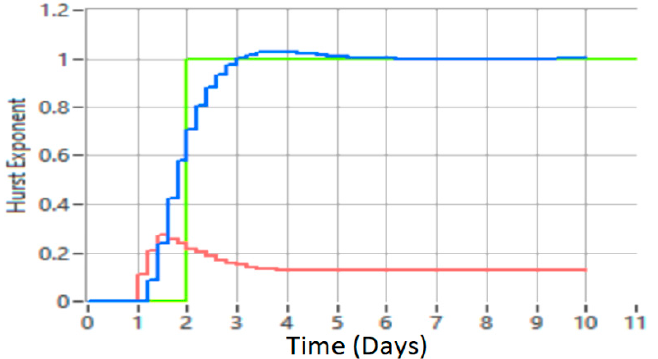
Figure 20. Comparison between the proposed MPC method with RBFNN and the classic MPC method (reference—green color, proposed method—blue color, and classic MPC method—red color).